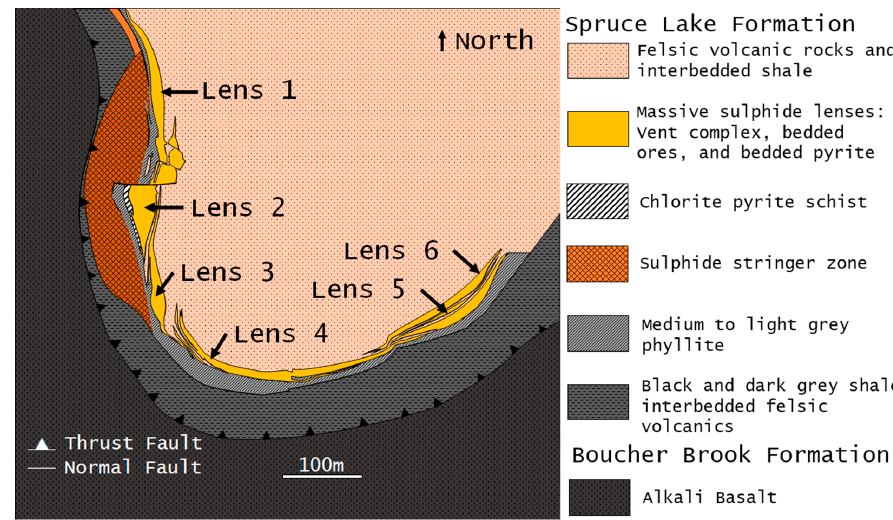
Figure 2. Geology at 150 m below the surface, showing the relative locations of the six lenses and their relationship to the stratigraphic units of the Spruce Lake Formation and Boucher Brook Formation (modified from